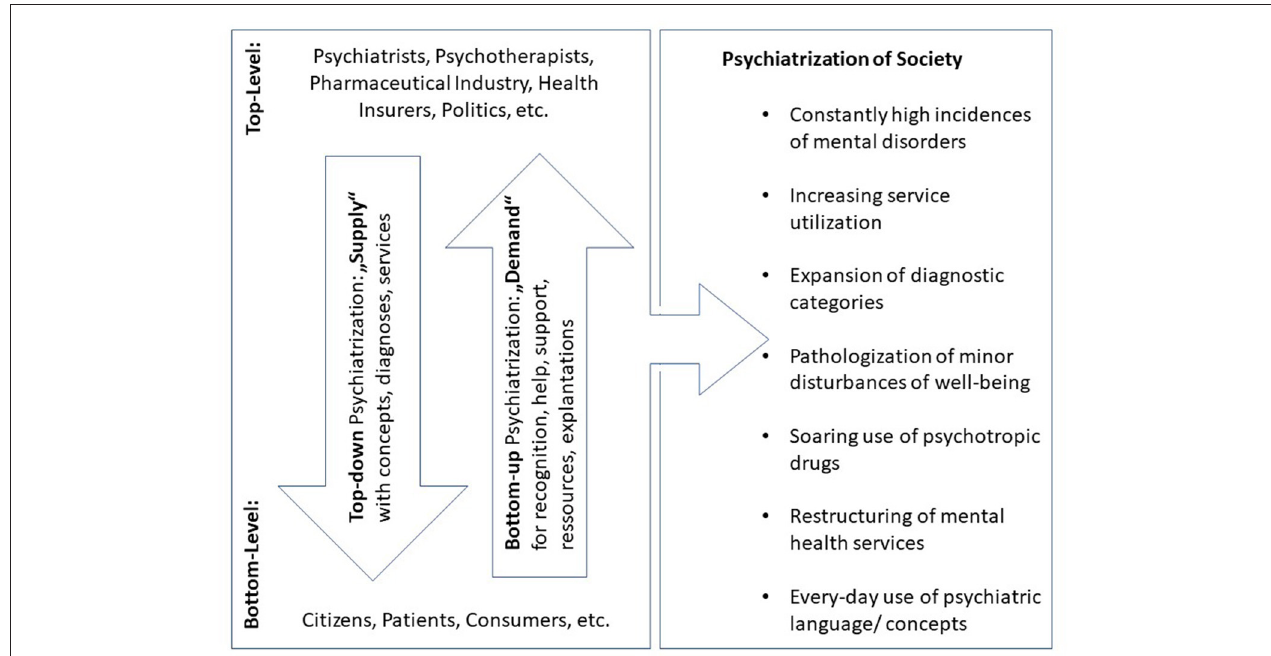
FIGURE 1 | Top-down and bottom-up psychiatrization (original figure). Main protagonists and vectors of psychiatrization consisting of heterogeneous sub-processes, of which the most important are listed on the right side of the figure.